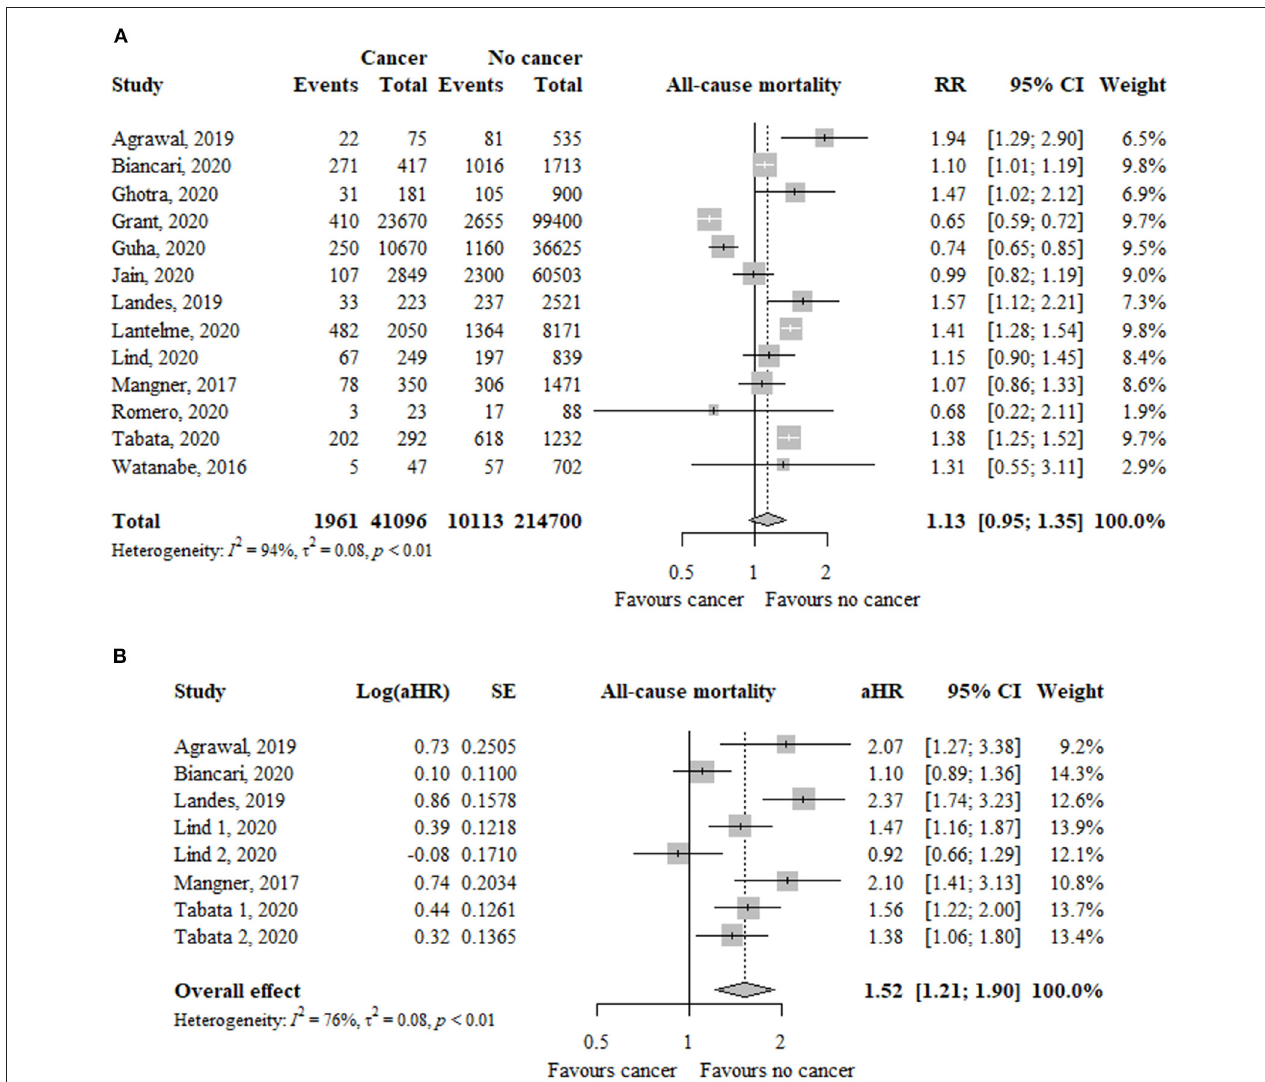
FIGURE 2 | Association between cancer and all-cause mortality in TAVR patients using (A) risk ratios and (B) adjusted hazard ratio as effect measures. RR, relative risk; aHR, adjusted hazard ratio; CI, confidence interval; TAVR, transcatheter aortic valve